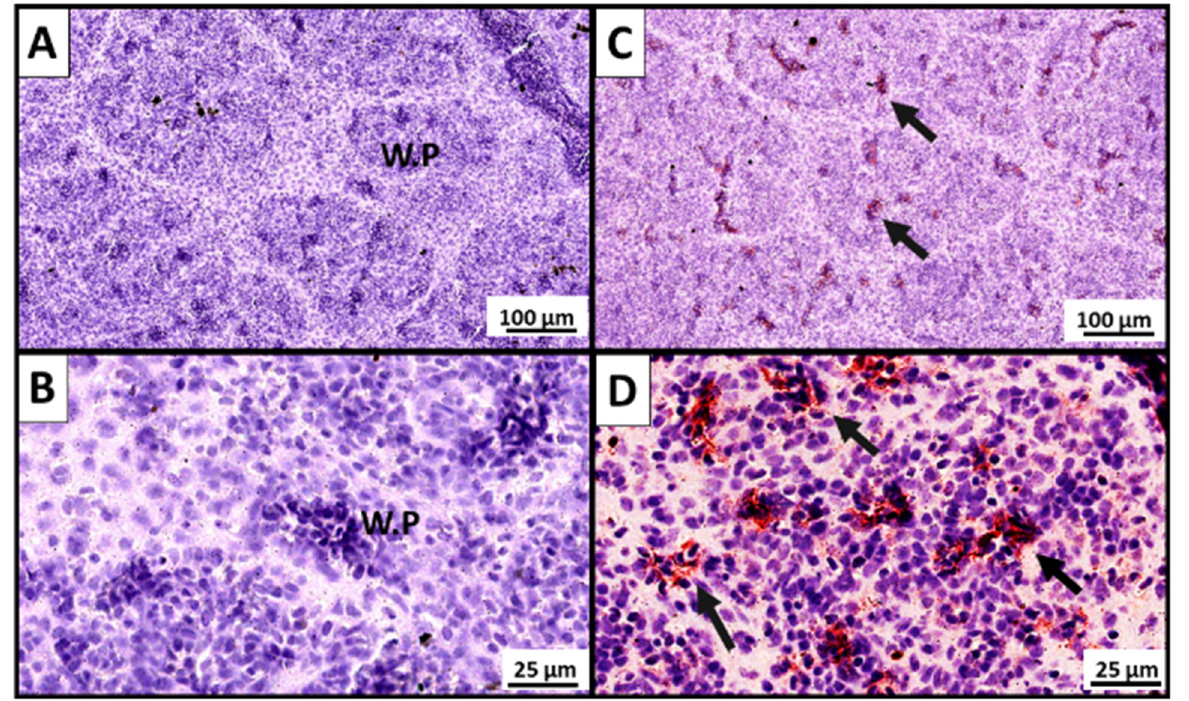
Figure 4. Detection of P33-specific antibodies in the spleen of P33-vaccinated fish. A modified immunohistochemistry protocol (inverted IHC; In.IHC) was used to demonstrate localization of P33-specific antibodies in spleen tissue of mock-vaccinated (injected with phosphate-buffered saline) fish ( A , B ; n ≥ 10) and fish injected with high dose of P33 ( C , D ; n ≥ 10) at 14 weeks post-vaccination. The pictures shown in panels ( A , C ) are from fish with plasma P33-specific IgM (A and B subtypes) OD values of 0.2 and 3.0, respectively. The red labeling spots (black arrows) show the binding of recombinant P33-protein to hypothesized P33-specific antibodies in the white pulp (WP) areas of spleen tissue of the P33-vaccinated fish in association with blood vessels.